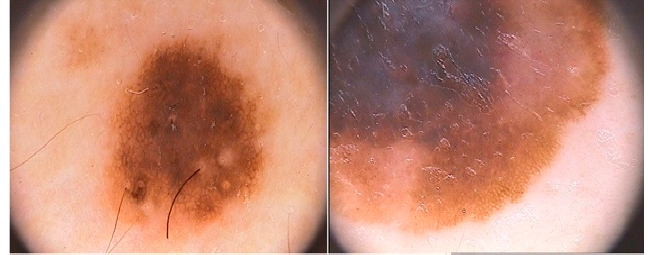
Figure 2. Examples of normal and abnormal images from the PH2 dataset.